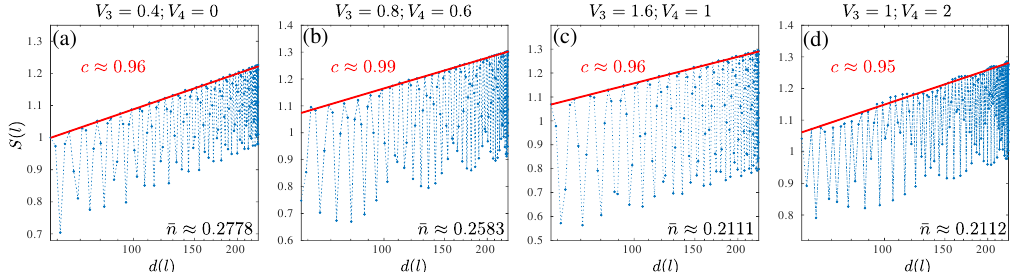
Figure 5: Scaling of entanglement entropy S ( l ) as a function of conformal distance (cid:0) π l (cid:1) d ( l ) = 2 N π sin at various points inside the floating phase with 1 (cid:28) l (cid:28) N the N size of a sub-block of consecutive ladder sites. The numerical values of the central charge extracted from the slope of the entanglement entropy are in good agreement with the theory prediction c = 1 for a Luttinger